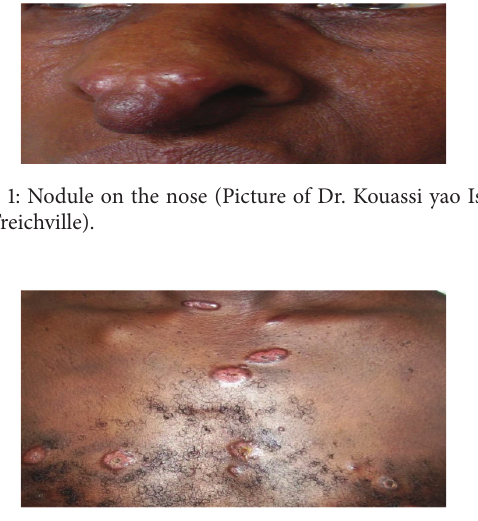
Figure 2: Papule of the chest (Picture of Dr. Kouassi yao Isidore, CHU Treichville).